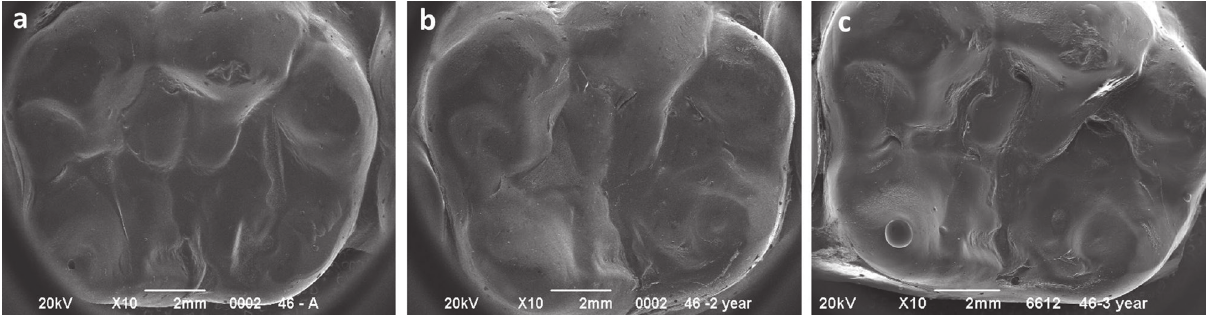
Figure 3- Representative scanning electron microscopy (SEM) micrographs of the sealant at (a) the baseline, (b) after 2 years, and (c) 3 years of clinical follow-up. The wear of the sealant formed an irregular surface, which is more evident after 3 years, favoring biofilm accumulation